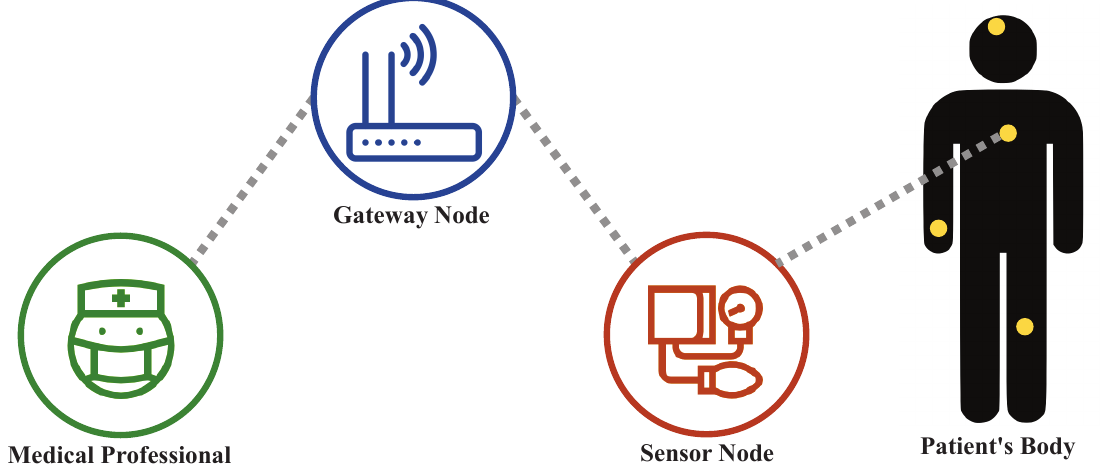
Figure 1. The Architecture of User Authentication for Digital Healthcare